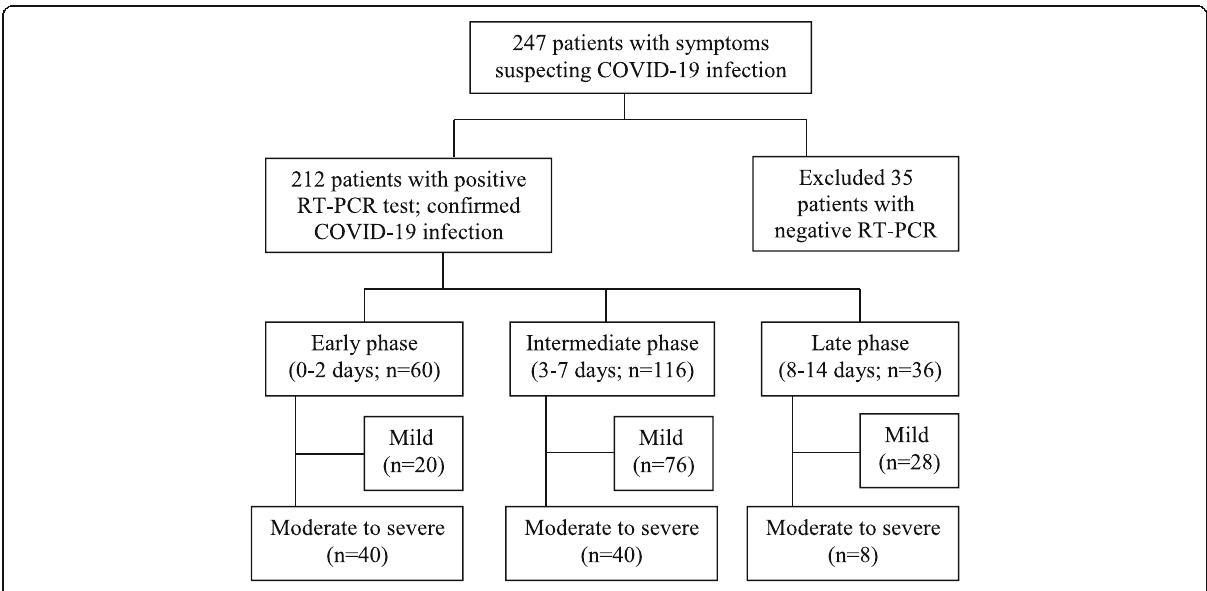
Fig. 1 Flowchart of patient